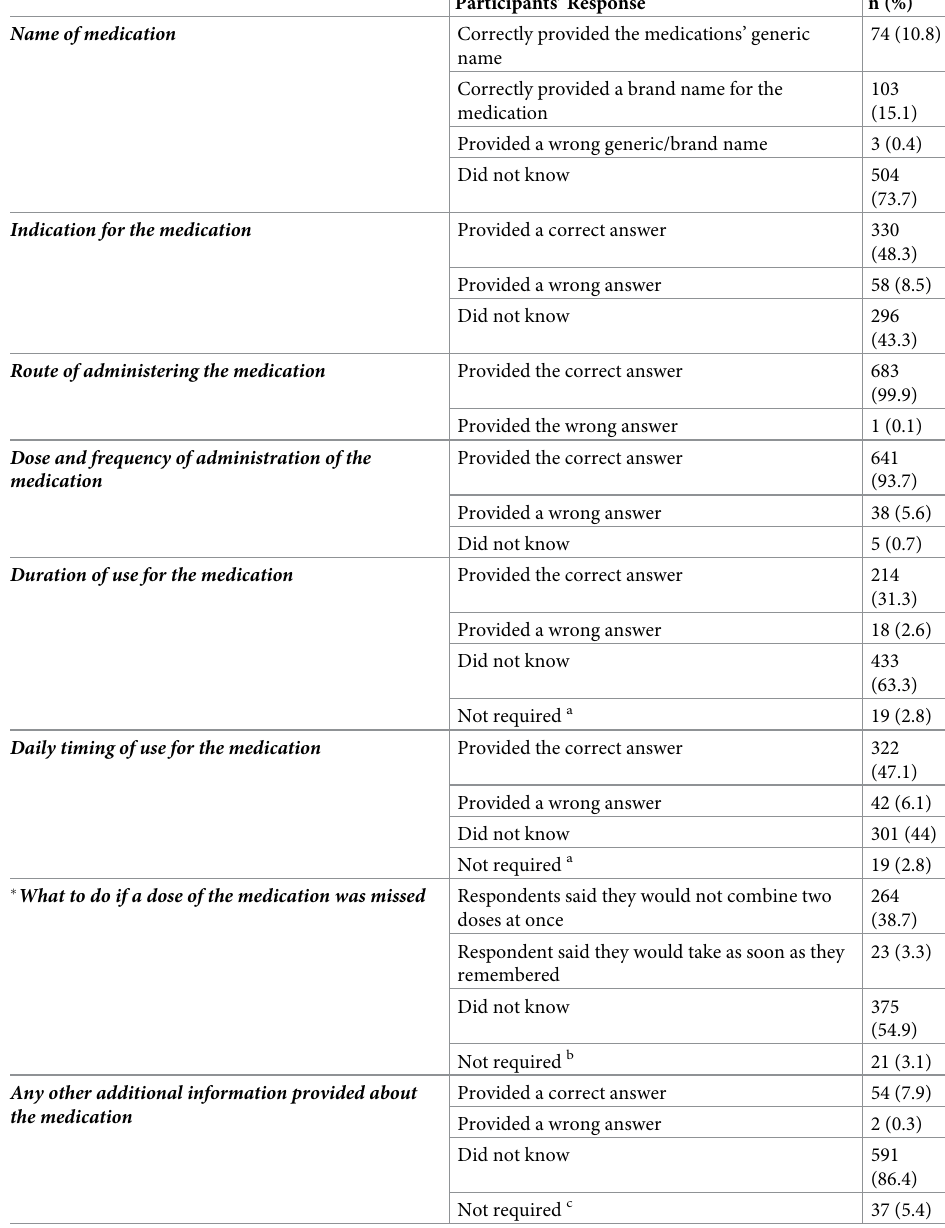
Table 4. Responses to the questions assessing respondents medication knowledge (n =